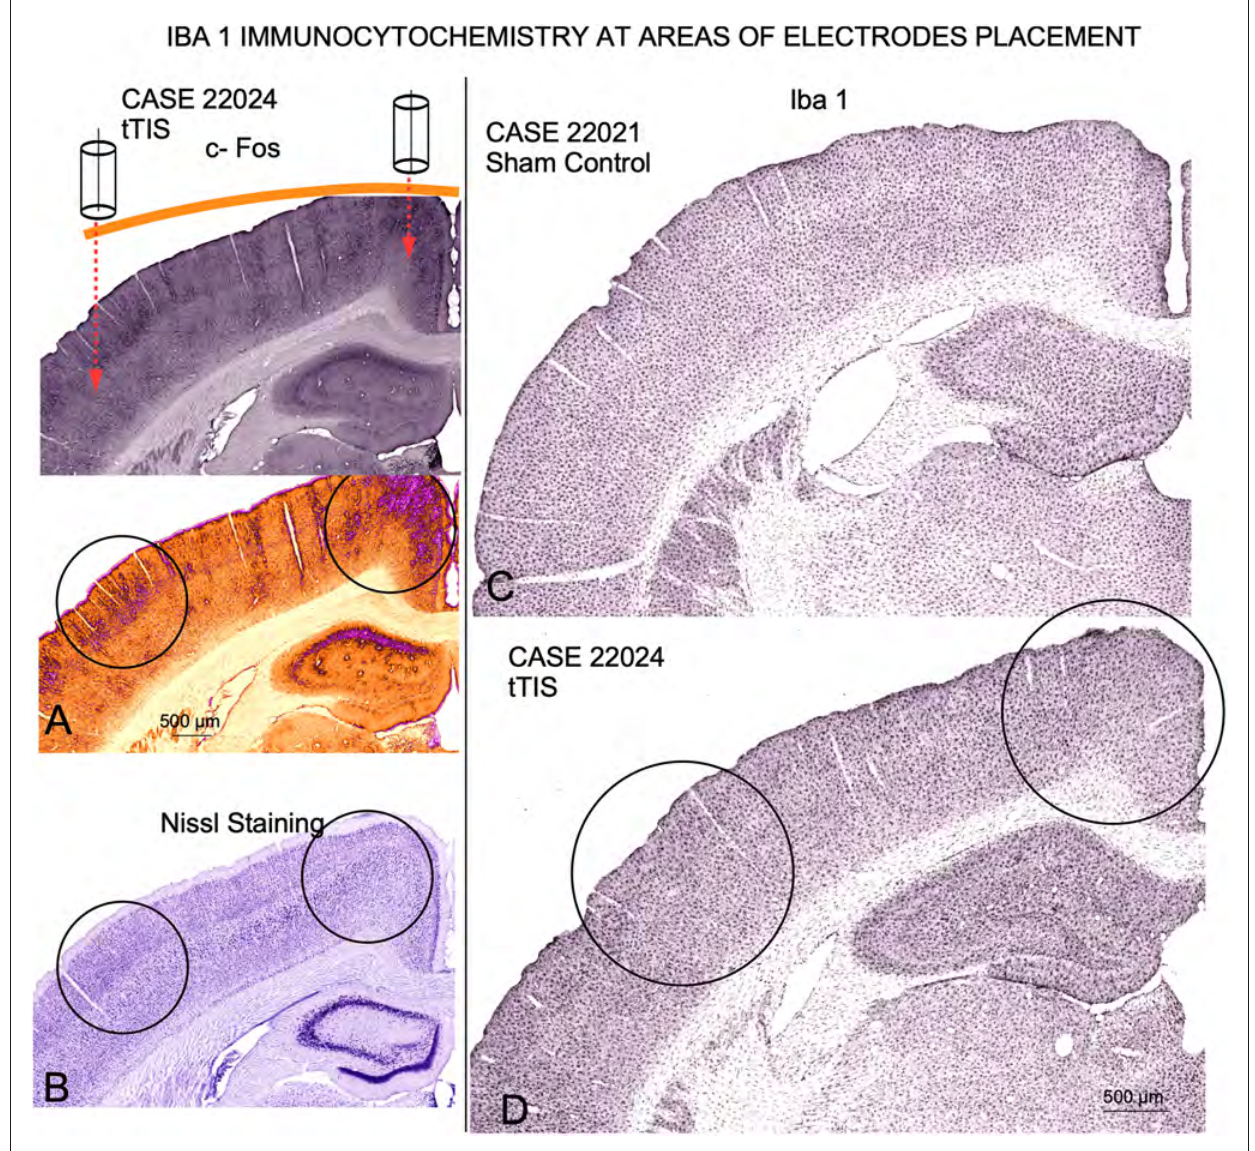
FIGURE9 Nissl staining and Iba1 immunoreactivity at the electrode placement coordinates. (A) c-Fos immunoreactivity and ICA pseudo color transformation in tTIS experimental case, for localization of reactive areas induced by current stimulation (circles). (B) Nissl staining of an adjacent serial section to sections shown in (A) . No chromatolysis, loss of neurons or architectural changes were detected. (C) Sham control Iba 1 immunostained section. (D) tTIS Iba 1 immunostained section at the coordinates of electrode placement. Note that glial architecture is well preserved along the